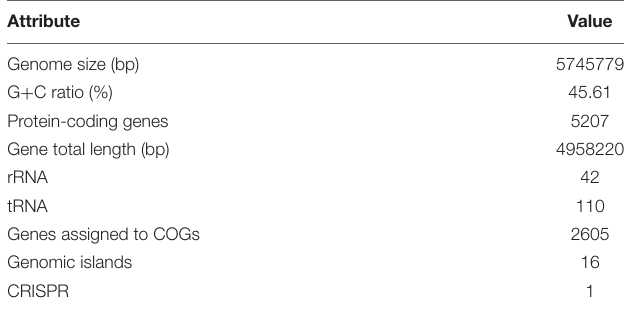
TABLE 2 | General features of the genome of the P. polymyxa strain HY96-2.